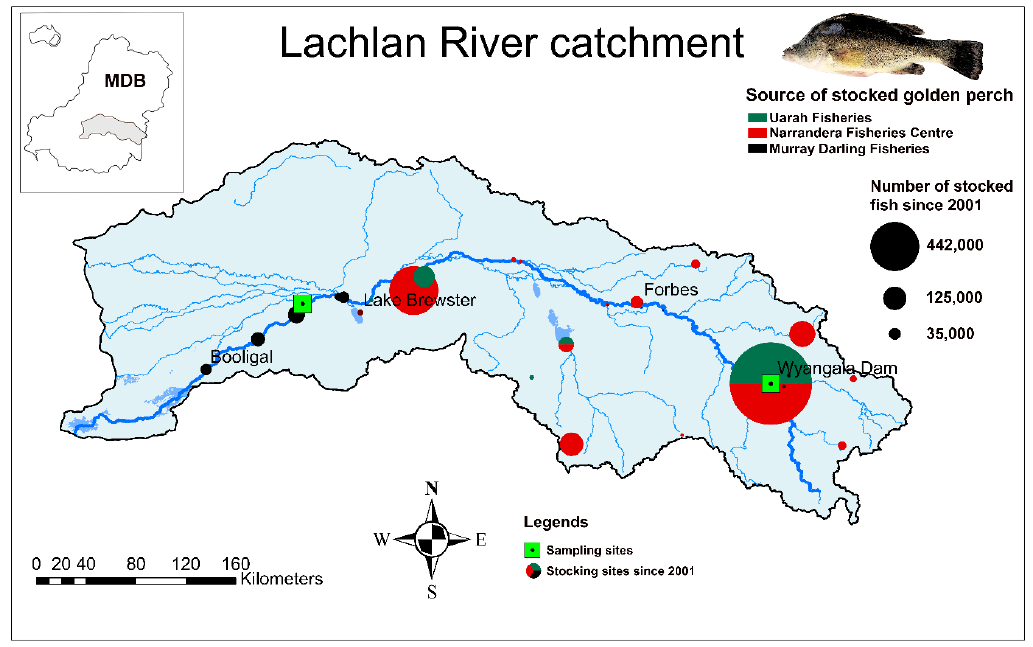
Figure 1. Cumulative number and hatchery-source of Macquaria ambigua (golden perch) stocked into the Lachlan River since 2001 (Unpublished data from NSW DPI 2019). Sampling sites cover the Upper Lachlan (above Wyangala dam) and Lower Lachlan (Downstream Lake Brewster). Sampling sites represent the locations from where fish for this study were